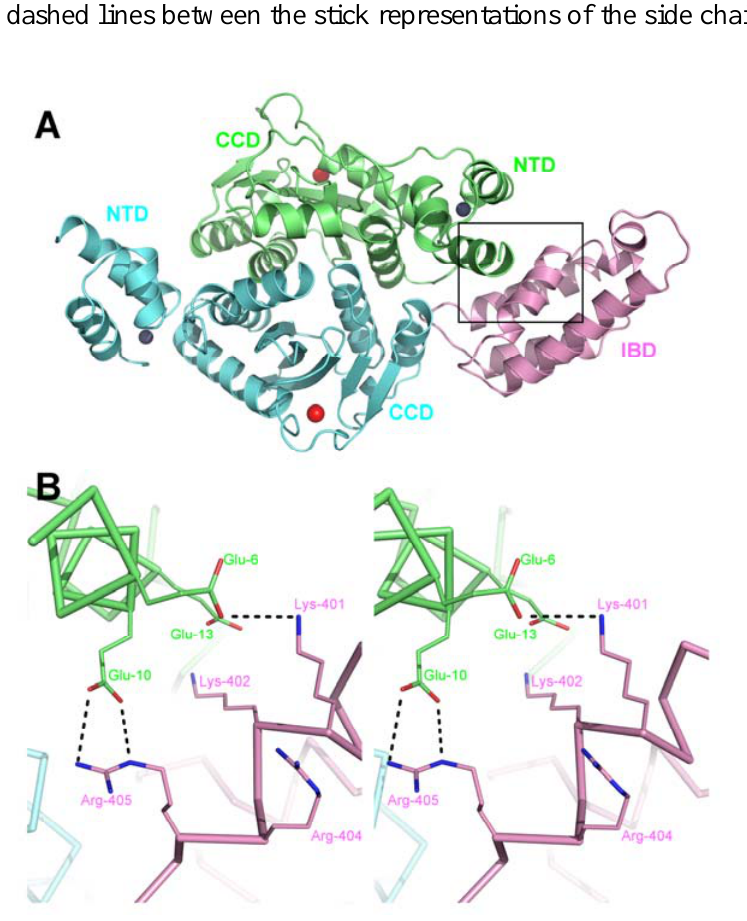
Figure 5. The interaction between the IBD and IN NTD. A. Cartoon representation of the HIV-2 IN and LEDGF co-crystal structure (PDB ID 3f9k) with the IN dimer NTD+CCD IBD colored green (chain A) and cyan (chain B) and LEDGF colored pink. Red spheres represent magnesium ions in the IN active sites and dark grey spheres represent Zn 2+ ions coordinated by the HHCC motif of the NTDs. B. Details of the NTD:IBD interface, showing the area enclosed by a black rectangle in A . The charge-charge interactions are shown as black dashed lines between the stick representations of the side chains